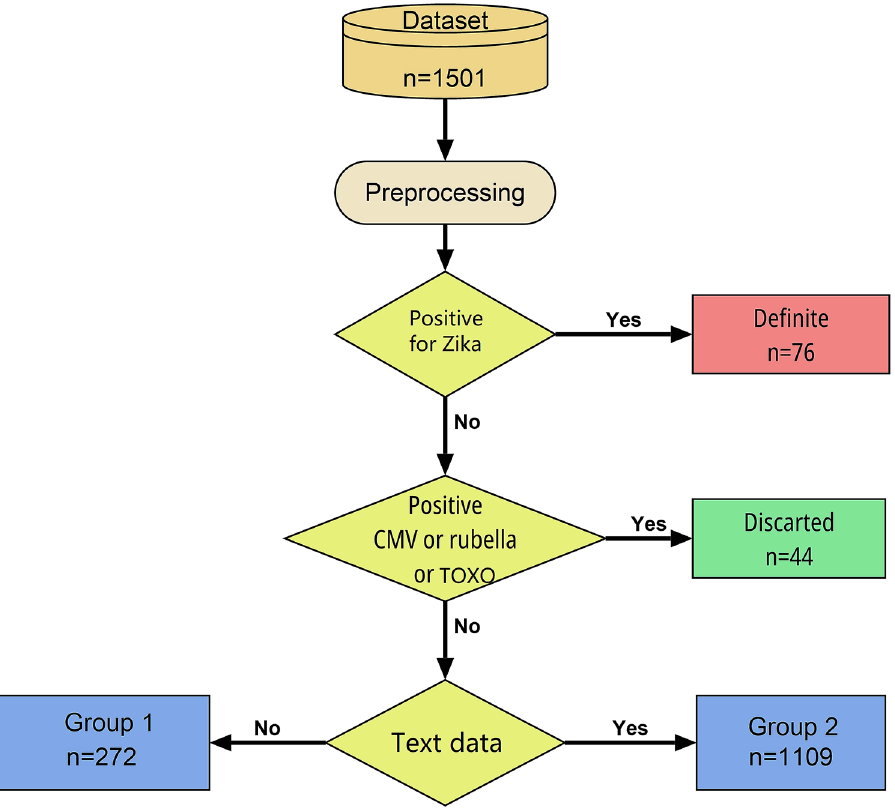
Figure 2. Flowchart describing the classification process, where CMV is positive serology for cytomegalovirus and TOXO is positive serology for Toxoplasma gondii